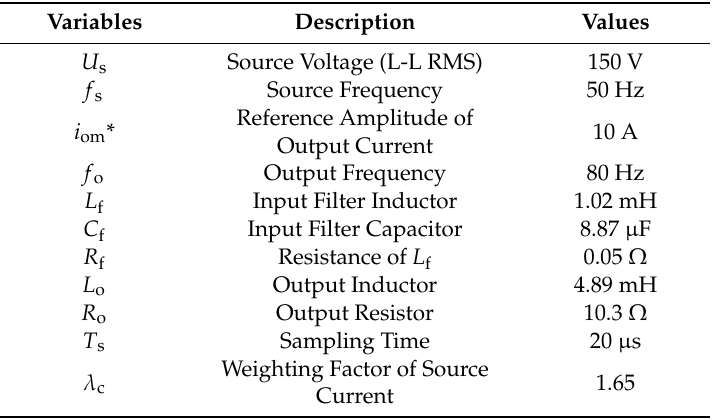
Table 3. Normal experimental parameters.